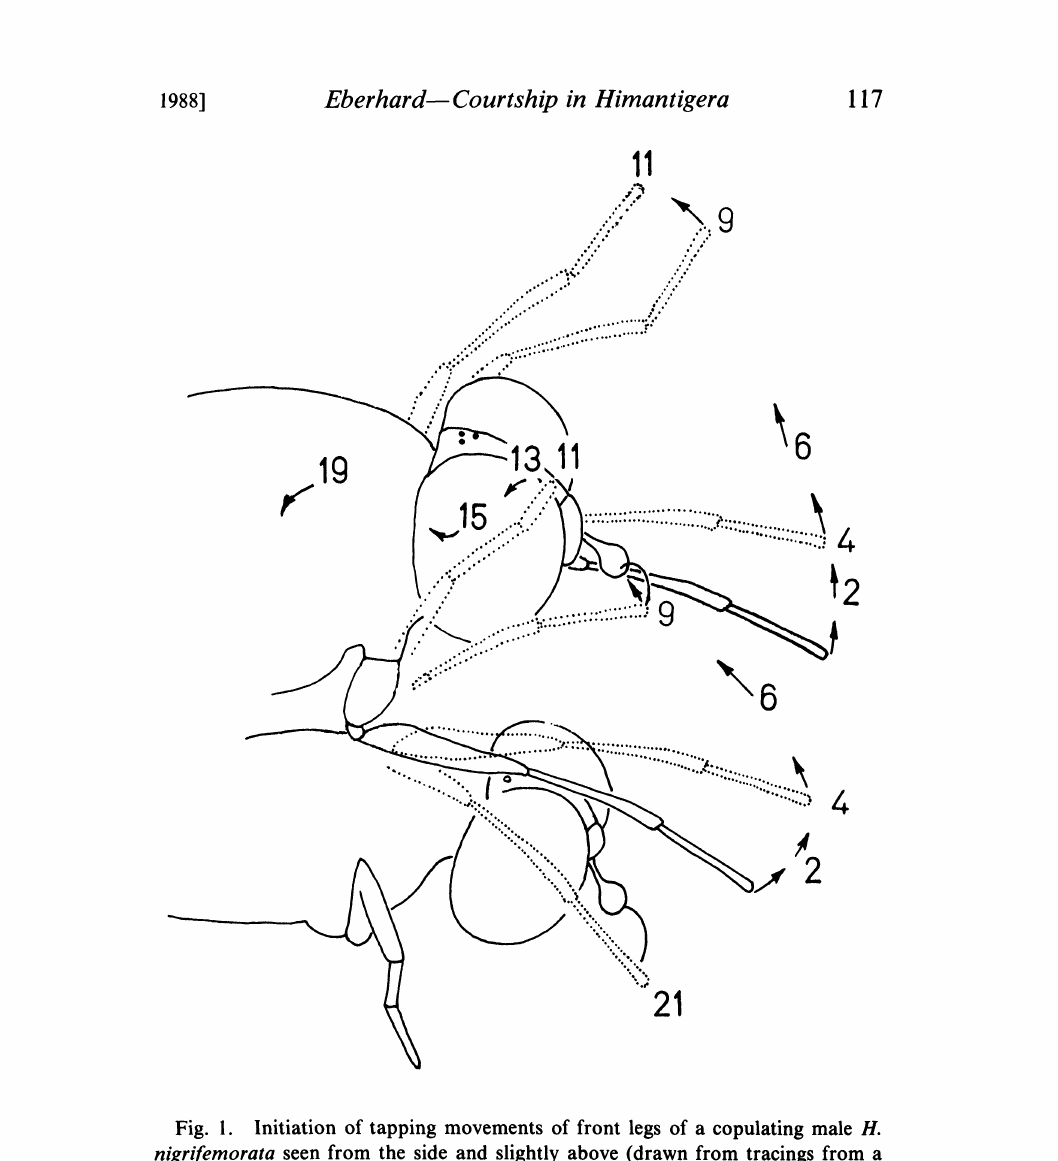
Fig. 1. Initiation of tapping movements of front legs of a copulating male H. nigrifemorata seen from the side and slightly above (drawn from tracings from a video recording). Numbers and dotted lines indicate number of frames (30 frames/ see.) after starting leg position (solid lines) and positions of legs at these times. Both legs were raised simultaneously until they were over the male’s head (frame 11); then, after a brief pause, the right leg was brought further back (frames 13-19), then tapped briskly downward (frame 21). It was not possible to determine from the videotape whether the tarsus contacted the female’s